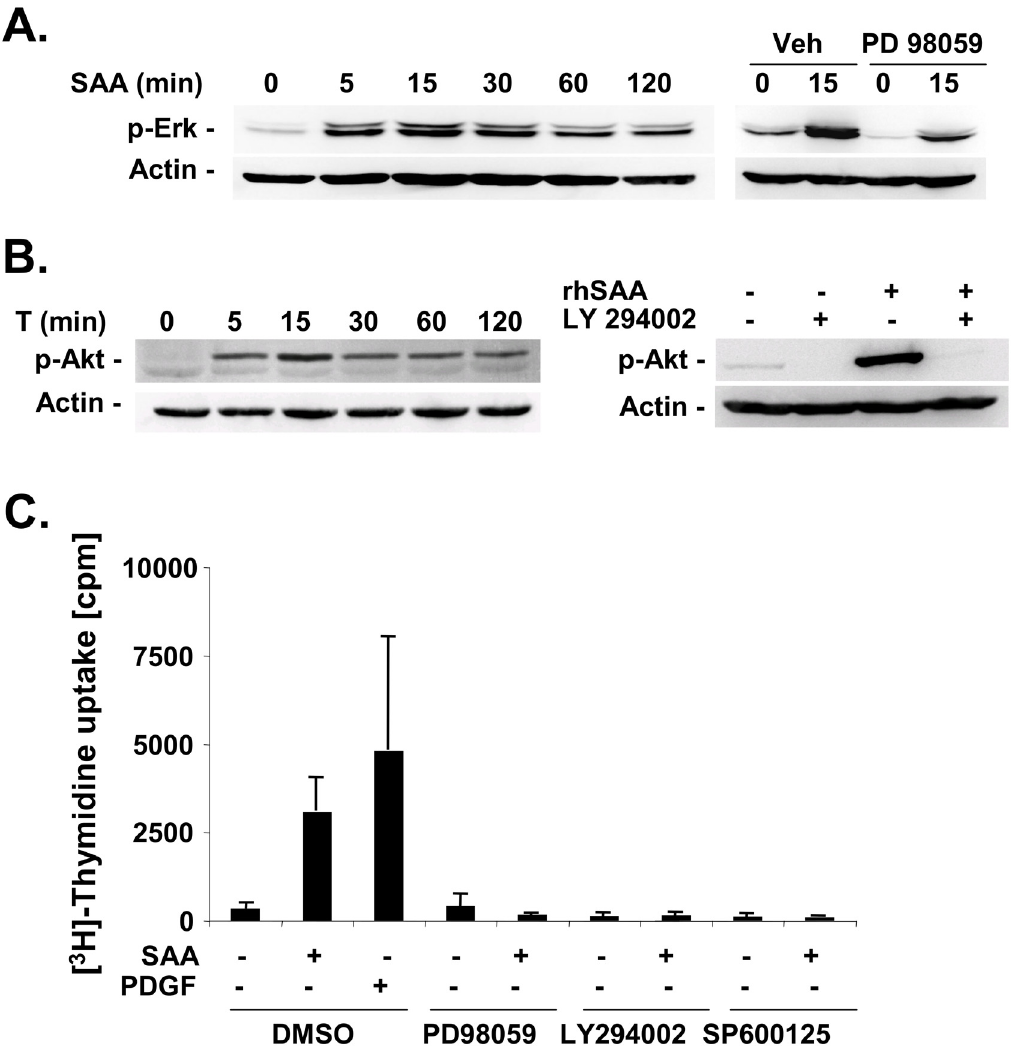
Fig 3. SAA induces HSC proliferation in an Erk-, JNK- and Akt-dependent manner. A-B. Activated rat HSCs were treated with rhSAA (5 μ M) for the indicated times. Phosphorylation of Erk at threonine 202 and tyrosine 204 ( A ), and Akt at serine 473 ( B ) was determined by western blot analysis in the absence or presence of MEK inhibitor PD98059 or PI-3 kinase inhibitor LY294002, respectively. C. Serum starved activated rat HSCs were pretreated with PD98059 (5 μ M), LY294002 (10 μ M) or SP600125 (20 μ M) followed by stimulation with rhSAA for 24 hours. 18 hours after stimulation cells were pulsed